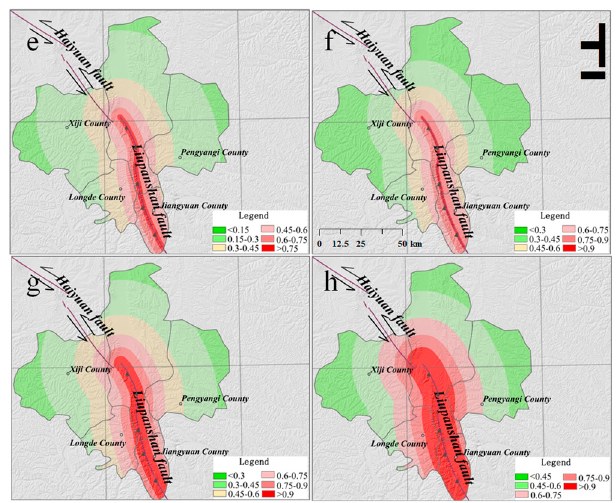
Figure 7. The distribution of the peak ground acceleration ( a max ) along the Haiyuan Fault and the Liupanshan Fault: ( a – d ): The seismic magnitude is Ms 7.0–8.5 along the Haiyuan Fault, and ( e – h ): The seismic magnitude is Ms 7.0–8.5 along the Liupanshan Fault.